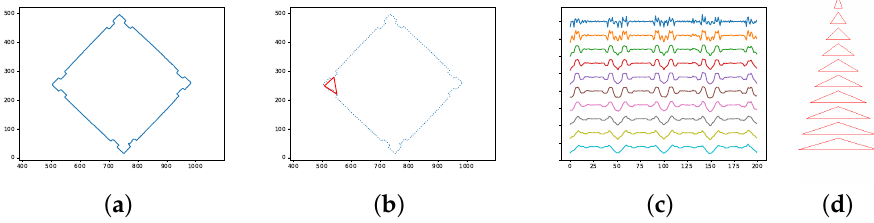
Figure 4. Shape descriptor based on the Triangle Area Representation (TAR). ( a ) Contour; ( b ) sampled contour (200 points) with an example of the considered triangle; ( c ) TAR descriptor (each line represents 200 normalized triangle areas; each area corresponds to point and its close neighbors) ( d ) illustrative triangles (indicating how far the neighbors are from the